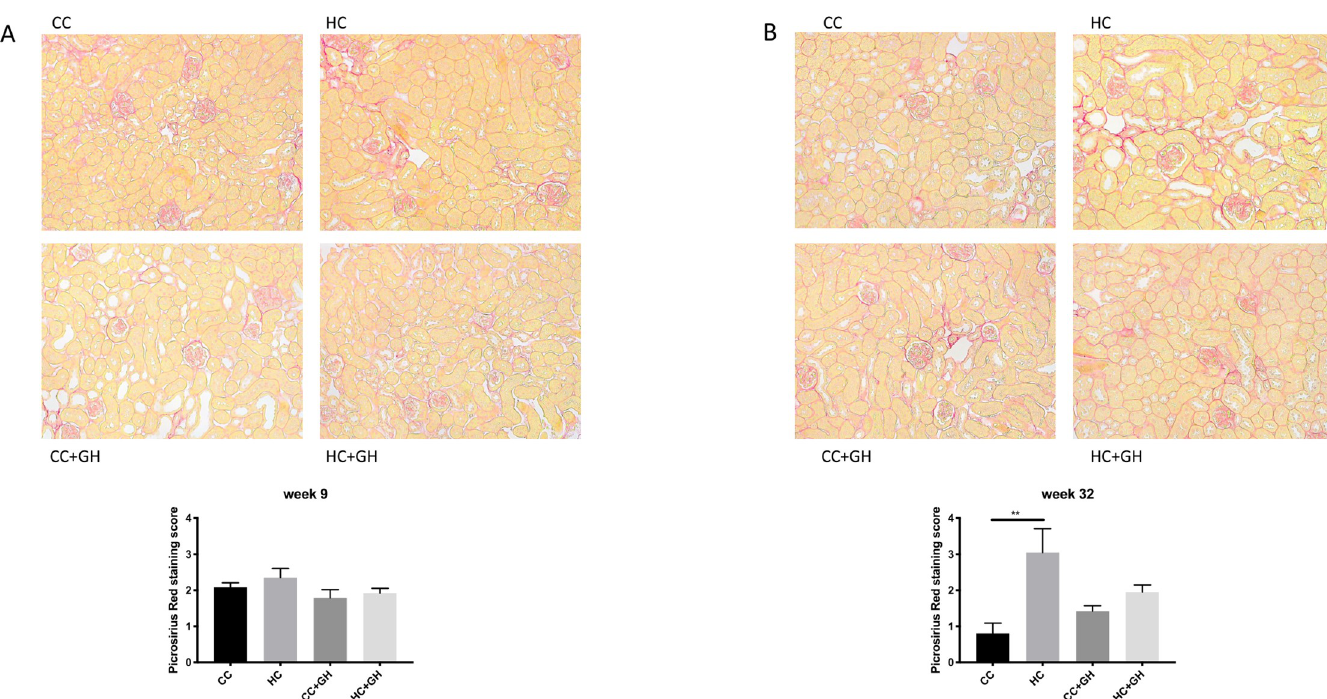
Fig 4. Renal fibrosis as measured by Picrosirius Red (PSR) staining. (A) Week 9 offspring representative images of PSR staining at 200x magnification, and quantitation, (B) week 32 offspring representative images of PSR staining at 200x magnification, and quantitation. Results expressed as mean ± SEM, n = 5–6, �� p < 0.01.